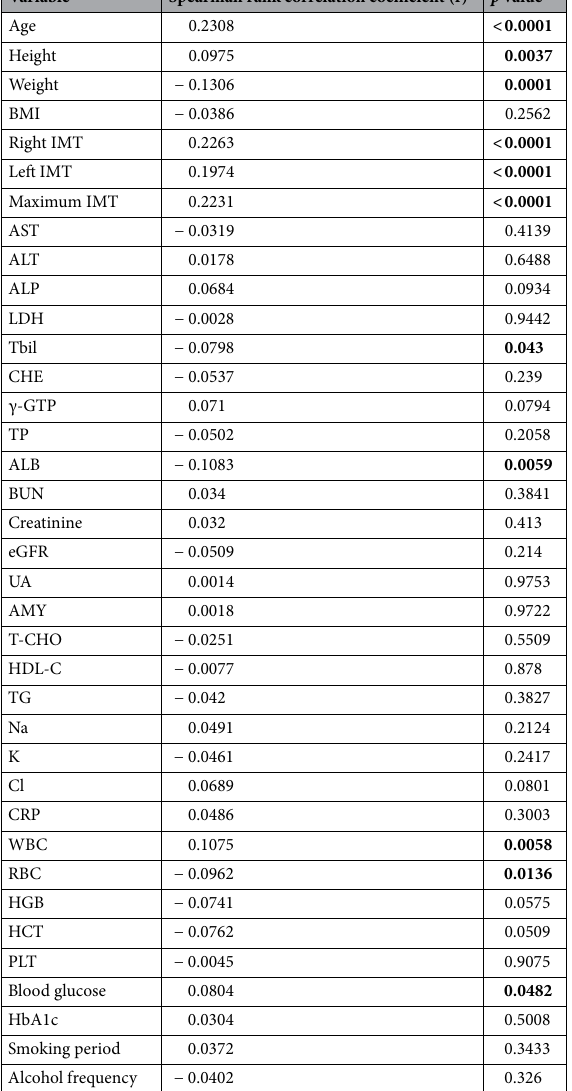
Table 3. Spearman correlation analysis between the serum SERPINE1 antibody levels and clinical features. A correlation analysis was performed to identify the relationship between SERPINE 1 antibody levels and the clinical features of the validation cohort. Correlation coefficient ( r ) and p values were calculated using Spearman correlation analysis. Significant correlations are marked in bold. BMI body mass index, IMT intima- media thickness, AST aspartate aminotransferase, ALT alanine aminotransferase, ALP alkaline phosphatase, LDH lactate dehydrogenase, Tbil total bilirubin, CHE choline esterase, γ-GTP gamma-glutamyl